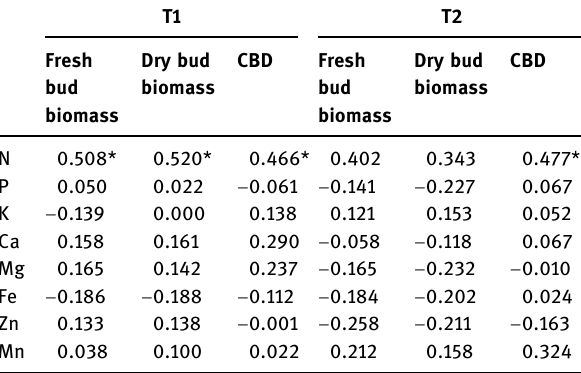
Table 3: Correlation between the leaf tissue macronutrient and micronutrient concentrations and fresh bud biomass ( kg ha − 1 ) , dry bud biomass ( g plant − 1 ) , and CBD yield ( g plant − 1 ) at the mid - vegetative ( T1 ) and late - vegetative ( T2 ) stages